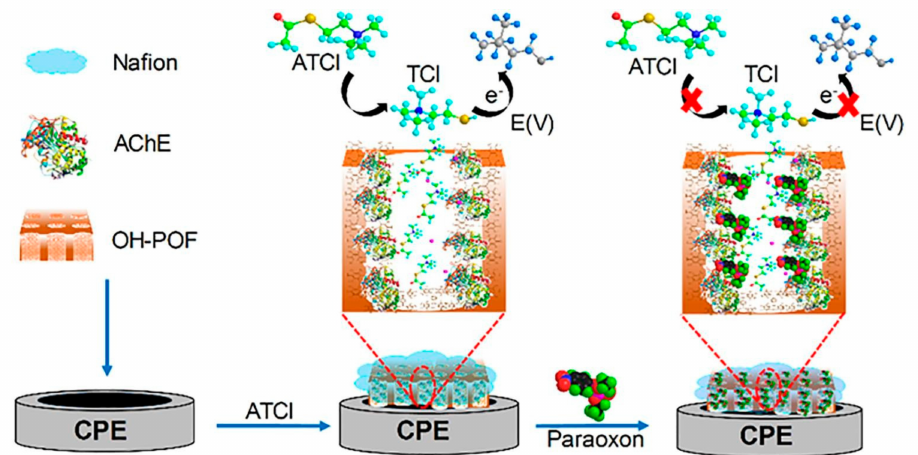
Figure 12. Illustration of the fabrication process of the NF/AChE/OH-POF/CPE biosensor. Repro- duced with permission of Elsevier from